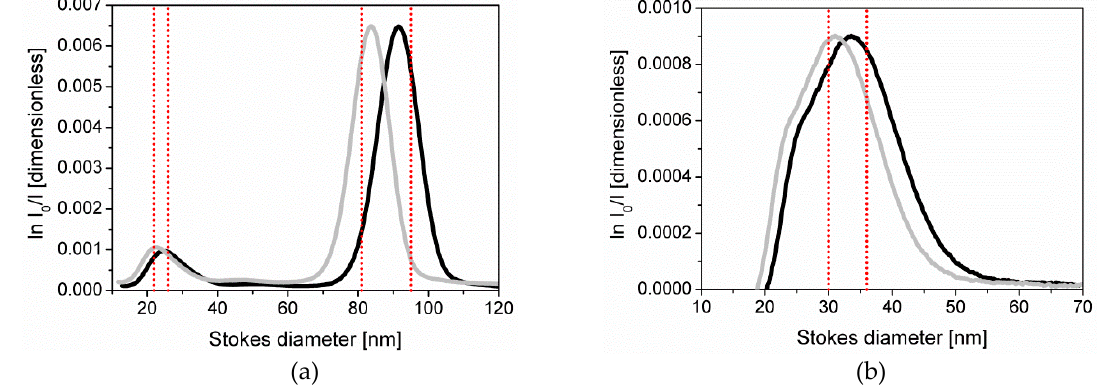
Figure 2. Overlay of representative light extinction-weighted PSDs of colloidal silica ERM-FD102 ( a ) and ERM-FD304 ( b ) obtained by the routine (black curves) and reference (gray curves) disc-CLS methods. The vertical dashed lines correspond to the certified ranges of the modal diameters for the two CRMs. The ordinates correspond to the natural logarithm of the ratio of the incident ( I 0 ) and transmitted light intensity ( I ). Table 2. Comparison of particle size results (mean ± expanded uncertainty) determined by routine and reference disc-CLS methods.